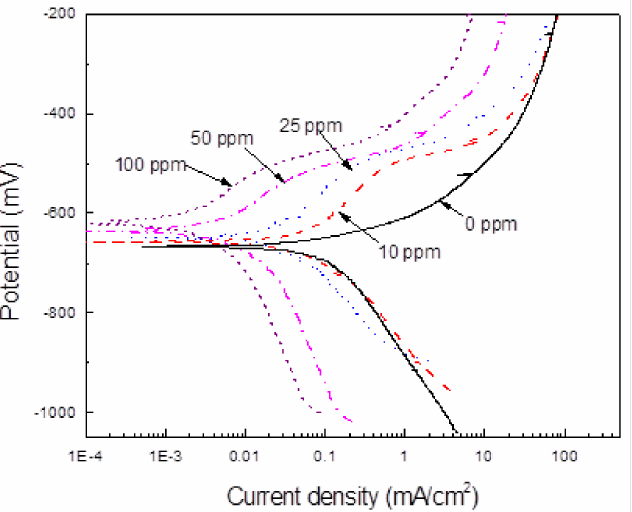
Figure 4. Effect of gemini surfactant concentration on the polarization curves for X-120 steel in a CO 2 -saturated NaCl solution at 50 ◦